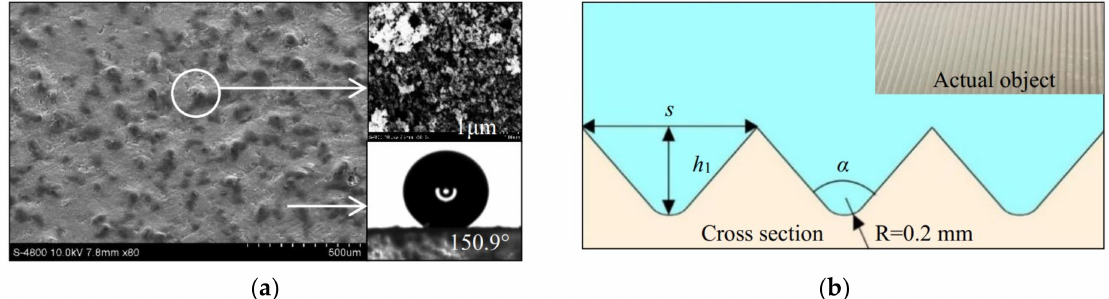
Figure 1. Schematic diagram of microstructured surfaces. ( a ) Electron microscope scanning image of superhydrophobic surface and surface droplet morphology. ( b ) Cross-section of the surface of V-shaped riblets and the actual